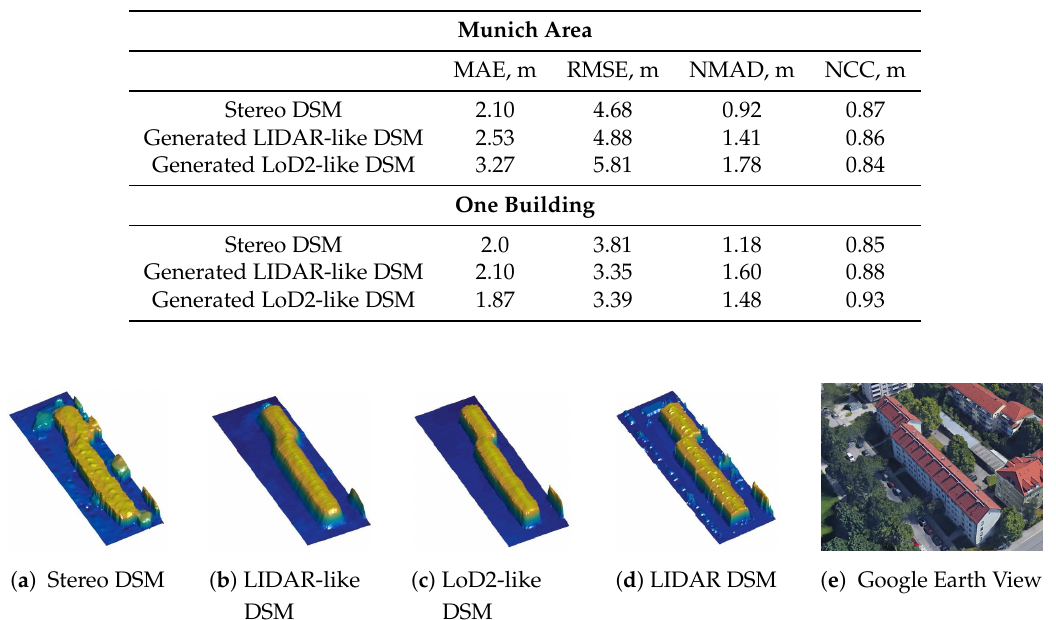
Table 2. Prediction accuracies of cGAN and cLSGAN models for all investigated metrics for LoD2-DSM and LIDAR-DSM datasets over the Munich area.